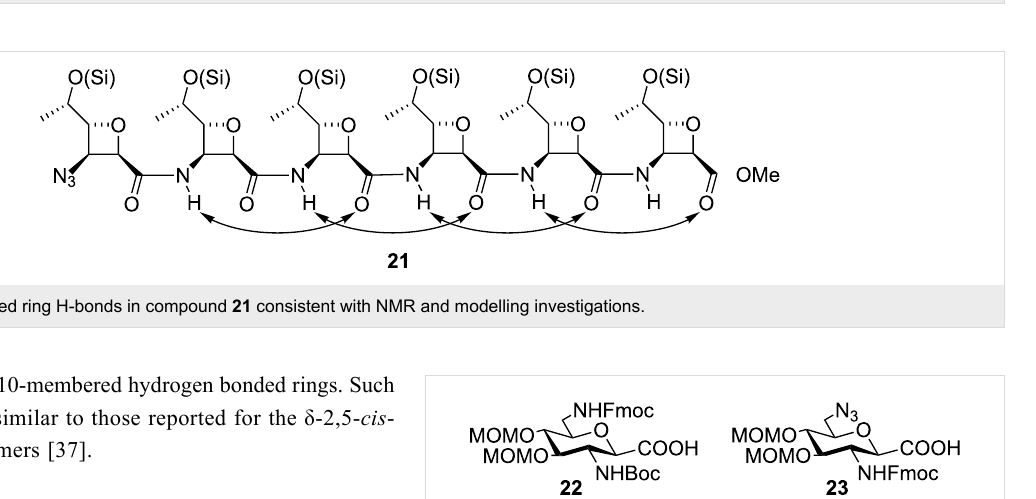
Figure 7: Structures of linear oxetane- β - and δ -SAA homo-oligomers 19 – 20 .